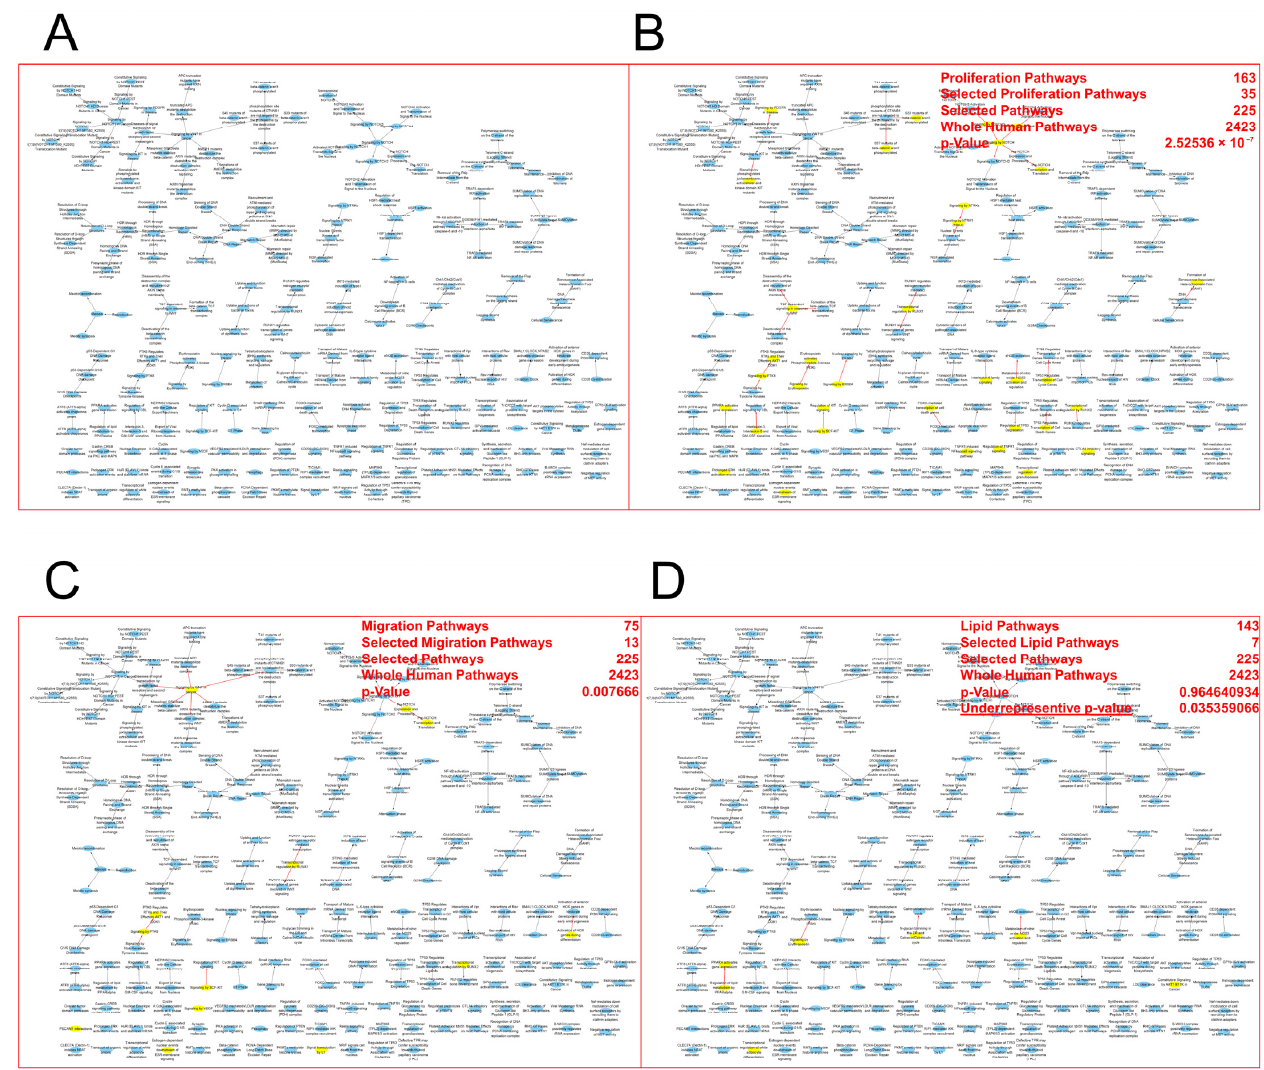
two clusters “Reproduction” ( p = 0.00029321) and “Circadian Clock” ( p = 0.00294656) were enriched but not denoted as cancer-related.